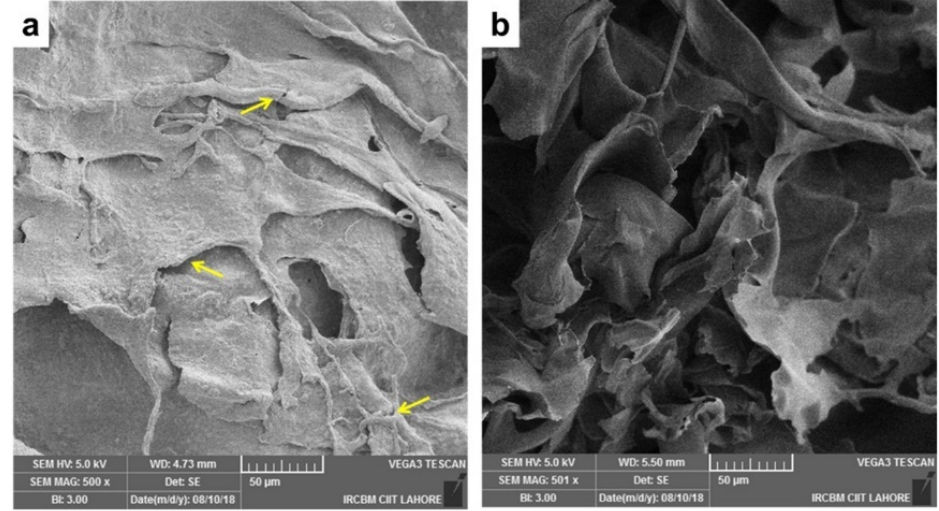
Figure 13. The SEM images showing the ( a ) lower surface and ( b ) upper surface of tri-layered membrane surface. The images are showing the presence of MC3T3-E1 pre-osteoblasts cells (yellow arrow) on surface [234].